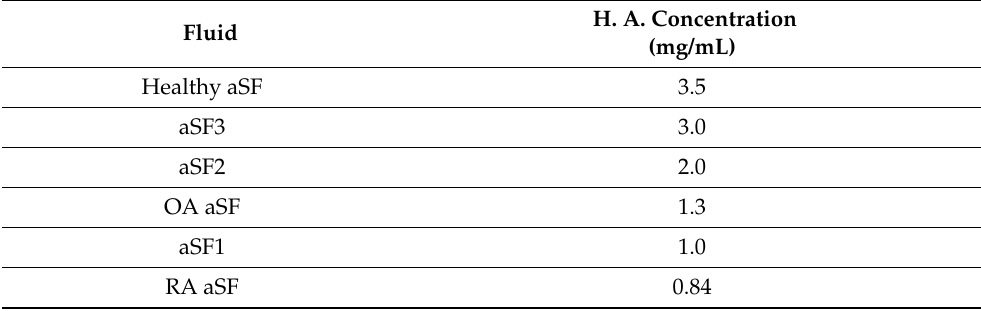
Table 1. Artificial Synovial Fluid (aSF) compositions (error = 0.01).